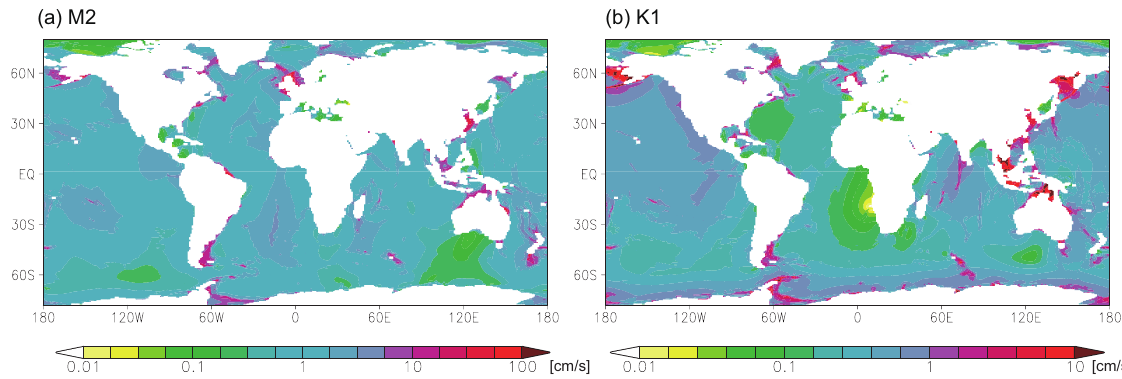
t Fig. 7. Speed of the barotropic tidal currents | u lt | of (a) M2 tide and (b) K1 tide averaged over 100h from 20:00 on day 6 to 24:00 on day 10. The colors are the same as in Fig. 1 of Müller et al. (2010), and the units are cms − 1 . | t of (a) M2 tide and (b) K1 tide averaged over 100 Fig. 7. Speed of the barotropic tidal currents | u lt hours from 20:00 on day 6 to 24:00 on day 10. The color shades are same as Fig. 1 of M¨uller et al. (2010), and the units are cm s − 1 .